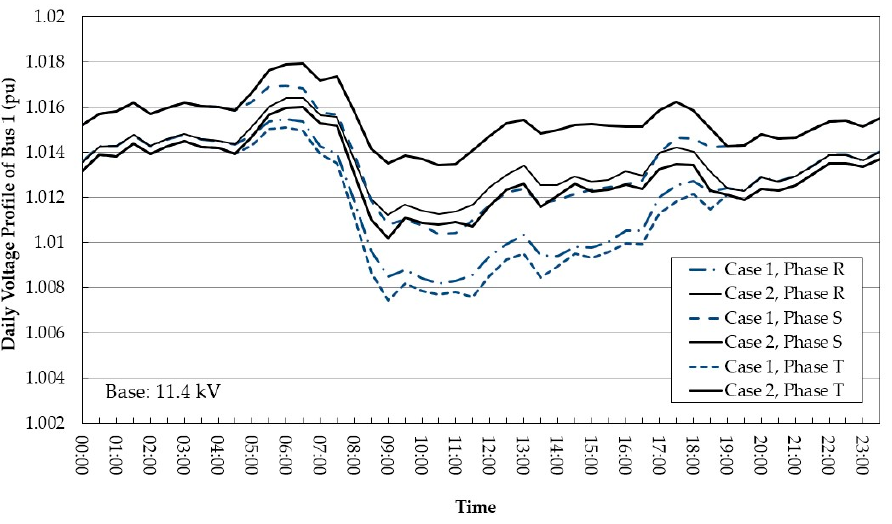
Figure 14. Voltage variation comparison on Bus 1 for Case 1 and Case 2.